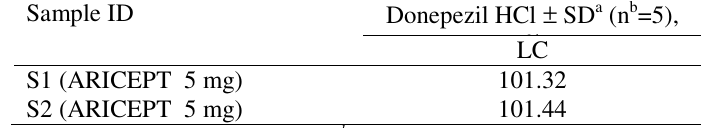
Table 5. Analysis results for donepezil hydrochloride tablets by the proposed LC